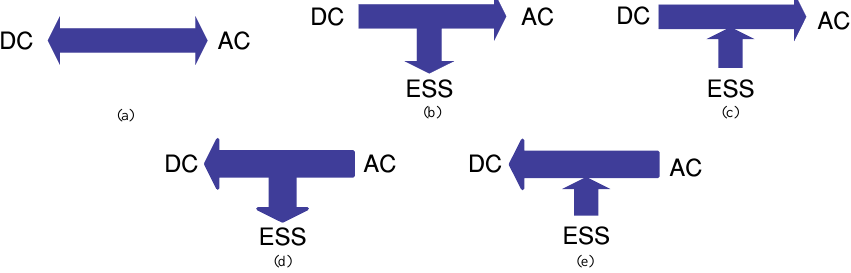
Figure 6. Power flow modes of the proposed hybrid modular multilevel converter (HMMC): ( a ) DC to AC mode and vice versa; ( b ) DC to the energy storage system (ESS) and AC mode; ( c ) DC and ESS to AC mode; ( d ) AC to DC and ESS mode; and ( e ) AC and ESS to DC mode.